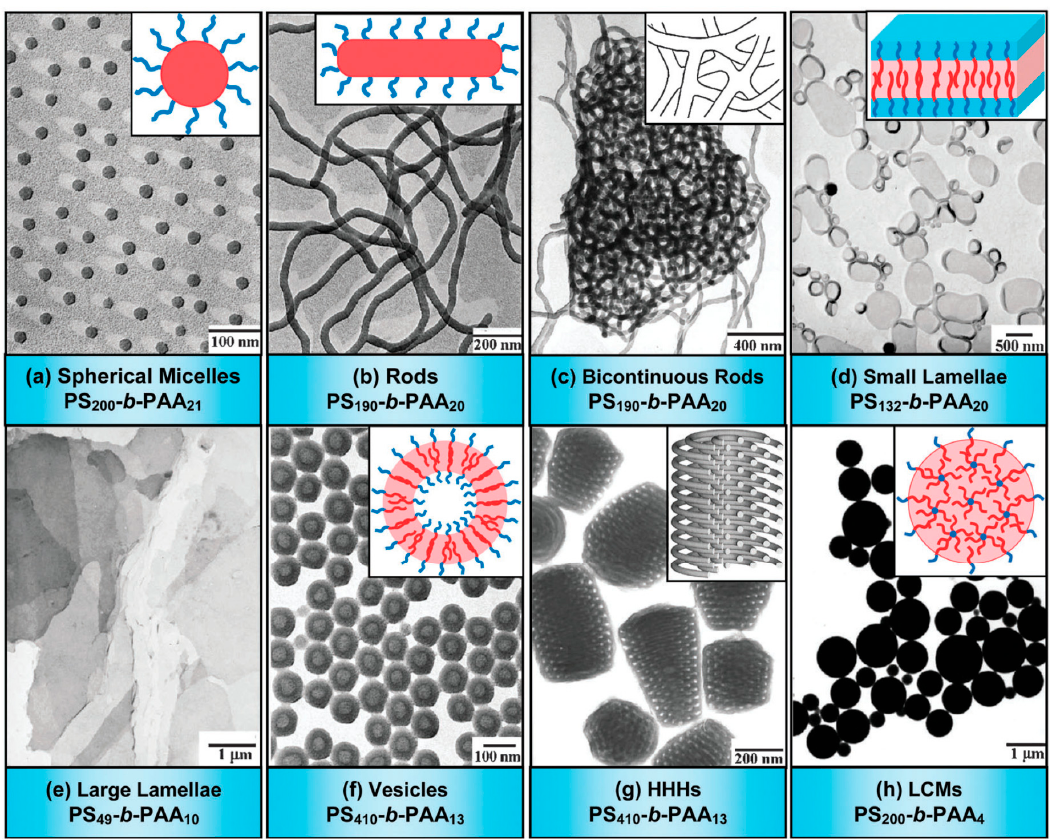
Figure 11. TEM images and corresponding schematic diagrams of various morphologies formed by amphiphilic PS m - b -PAA n copolymers( m and n denote the degrees of polymerization of PS and PAA, respectively): ( a ) spherical micelles; ( b ) rods; ( c ) bicontinuous rods; ( d ) small lamellae; ( e ) large lamellae; ( f ) vesicles; ( g ) hexagonally packed hollow hoops (HHHs); ( h ) large compound micelles (LCMs). Reprinted from Reference [69]. (Copyright (2012) Royal Society of Chemistry).